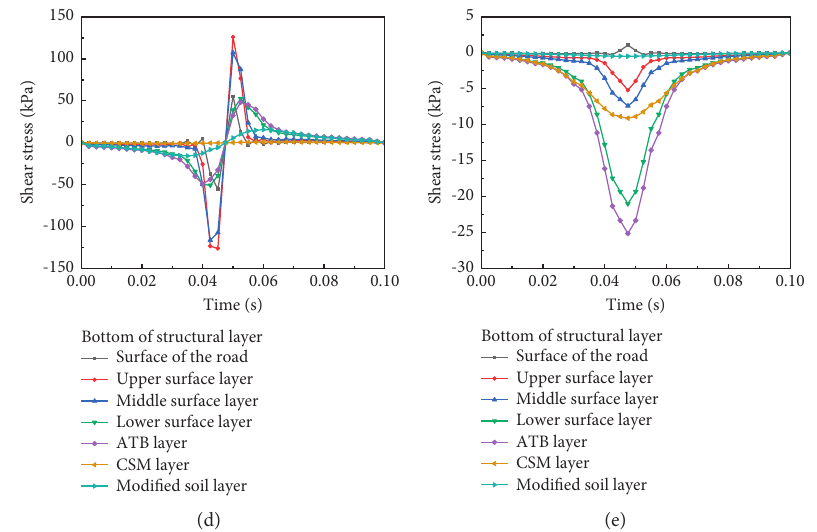
Figure 9: Time history curve of (a) vertical displacement, (b) vertical stress, (c) vertical micro strain, (d) longitudinal shear stress, and (e) transverse shear stress at each layer of structure